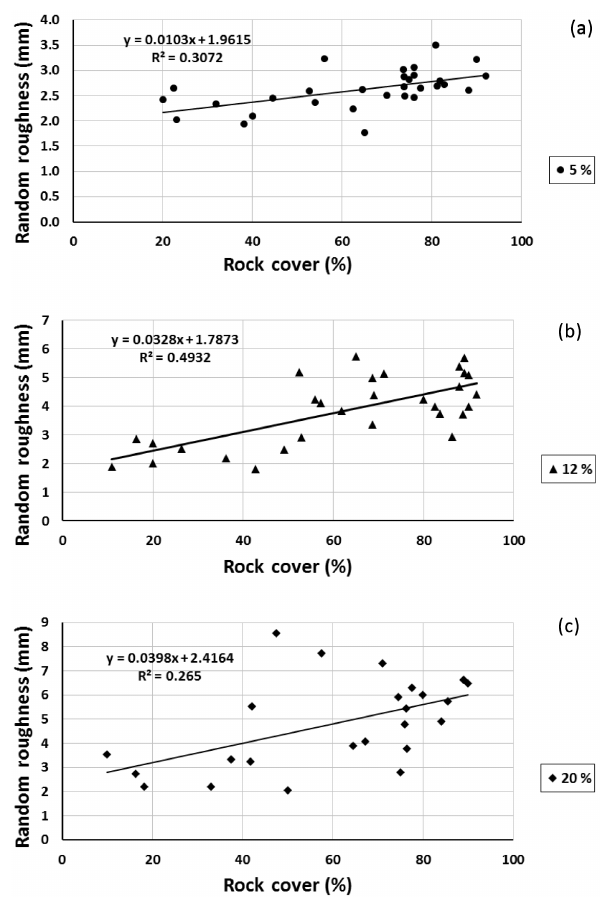
Figure 5. Random roughness as a function of rock cover on all sec- tions of the plots and both replications for (a) 5%, (b) 12%, and (c) 20% slope gradients.